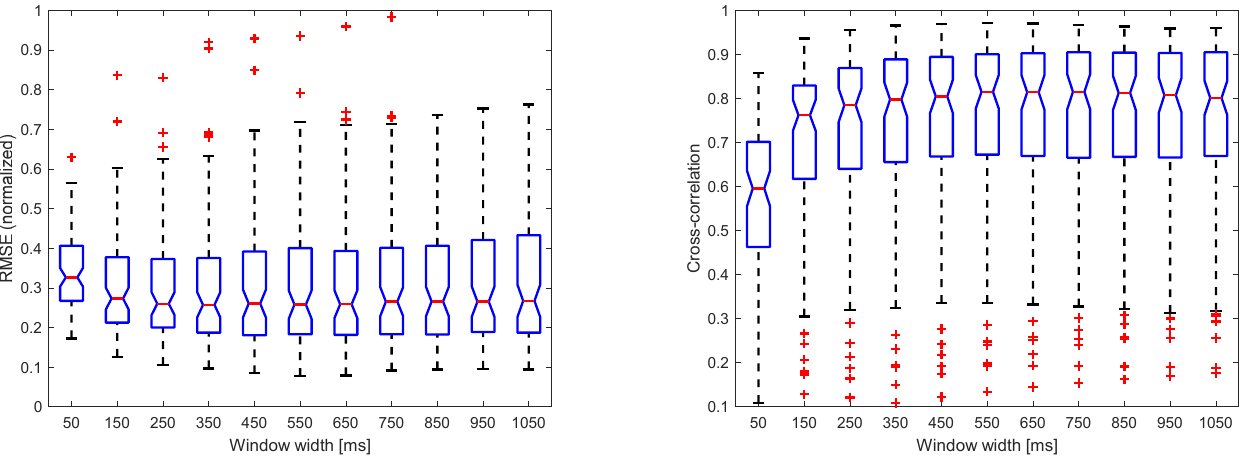
Figure A3. RMSE ( left ) and cross-correlation ( right ) of ENV algorithm for different window sizes.